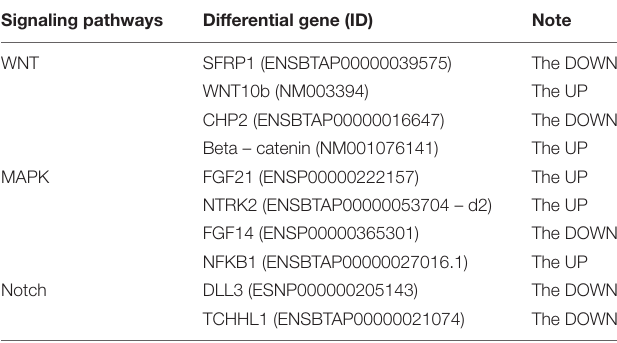
TABLE 3 | Genes enriched in the signal pathways related to hair follicle